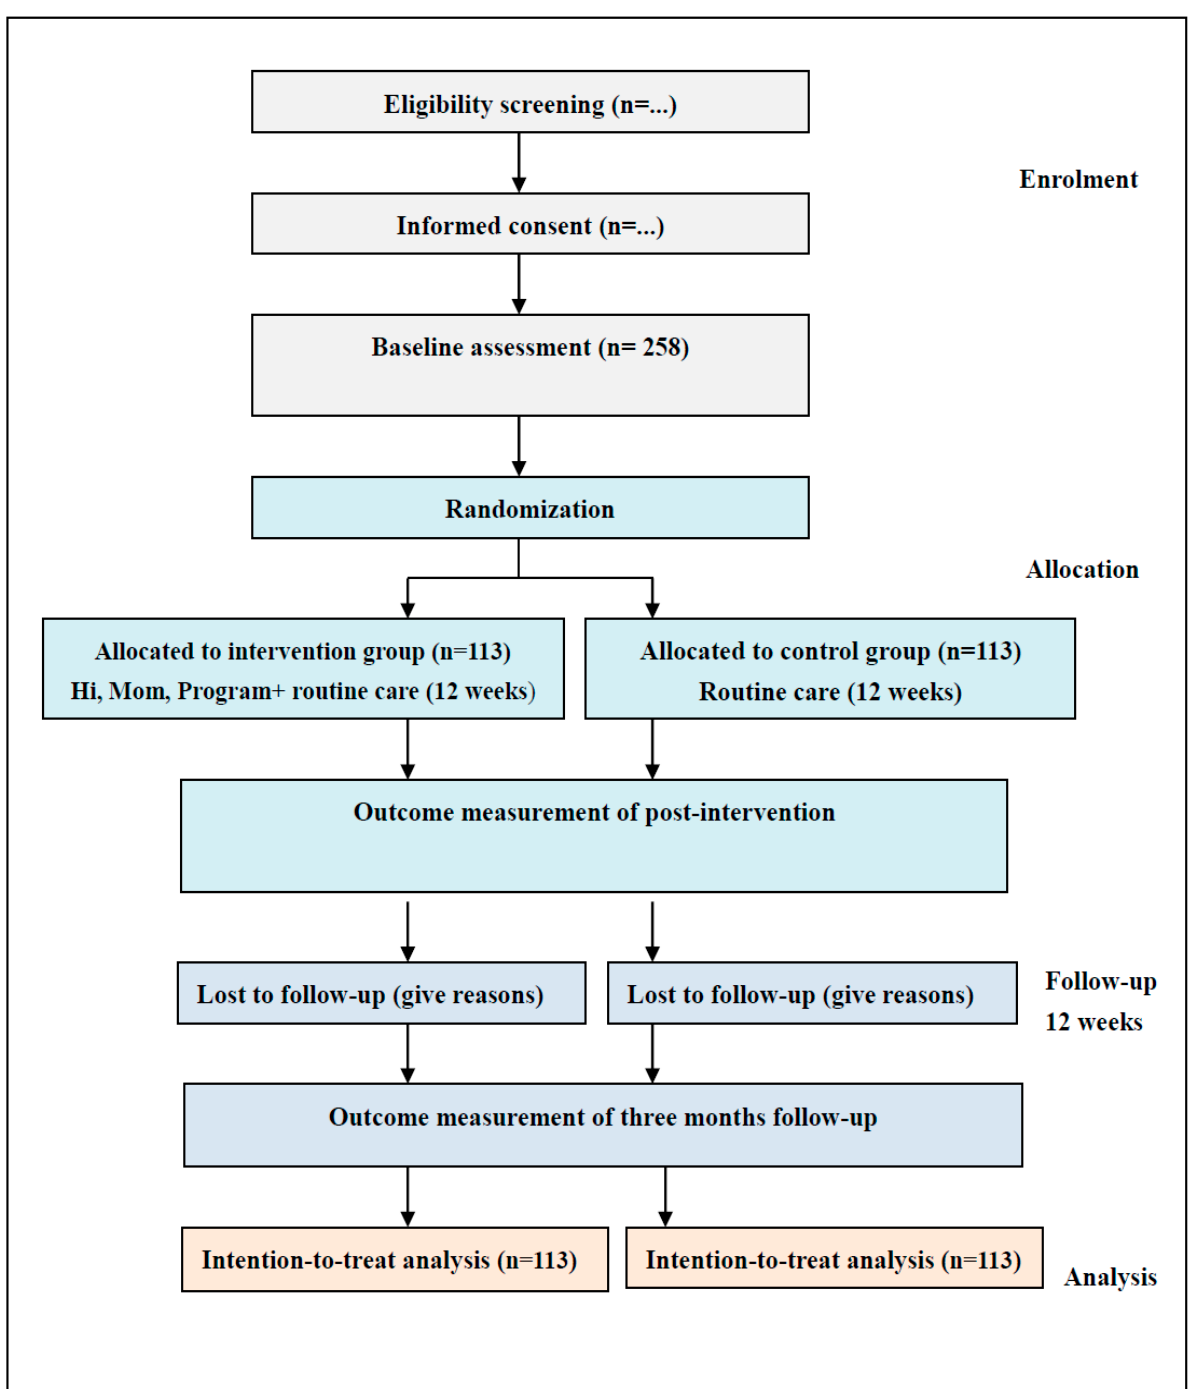
Figure 1. CONSORT flowchart of the study.